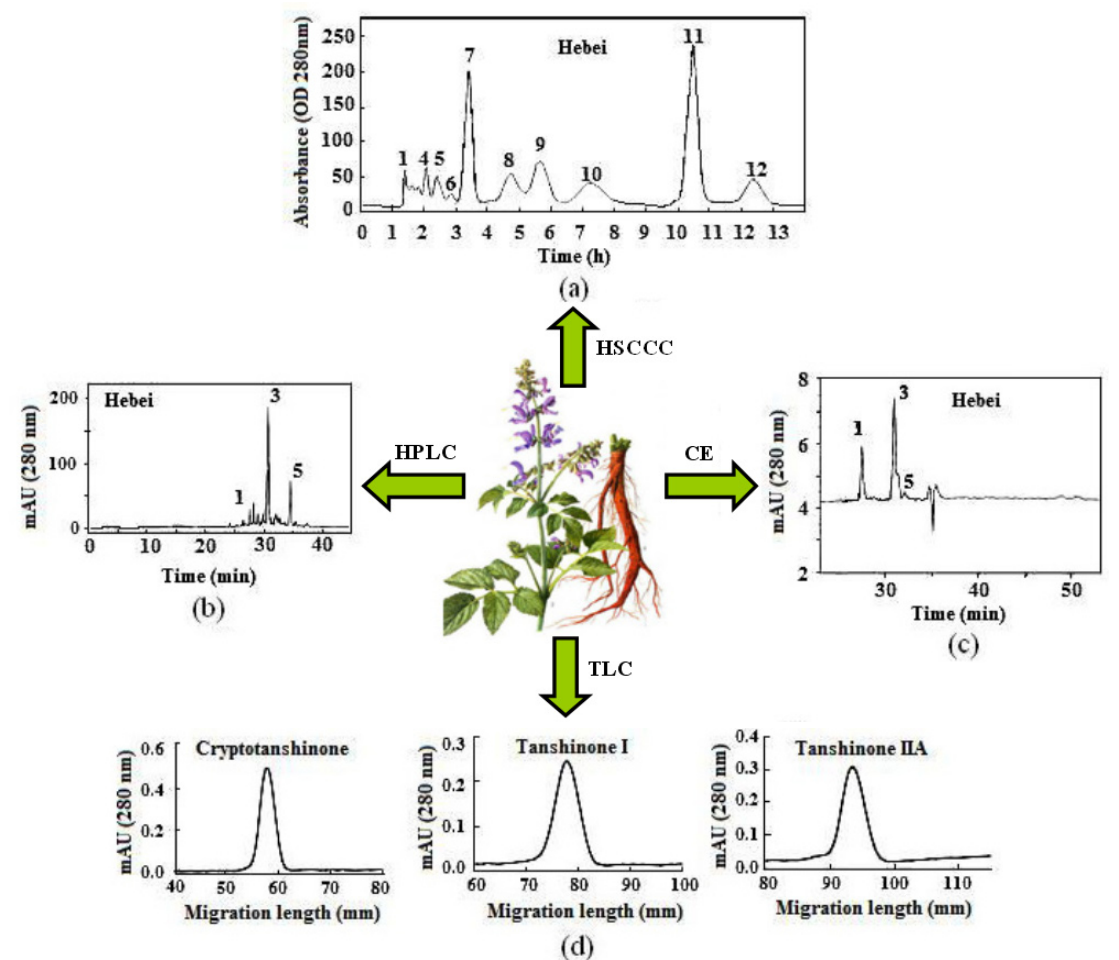
Figure 7. Fingerprinting chromatograms of HSCCC (a, peaks (7) cryptotanshinone; (8) tanshinone I; (11) tanshinone IIA), HPLC (b, peaks (1) cryptotanshinone; (3) tanshinone IIA; (5) tanshinone I), CE (c, peaks (1) cryptotanshinone; (3) tanshinone IIA; (5) tanshinone I), and TLC scanning (d) for crude samples of Dansheng from Hebei province, China